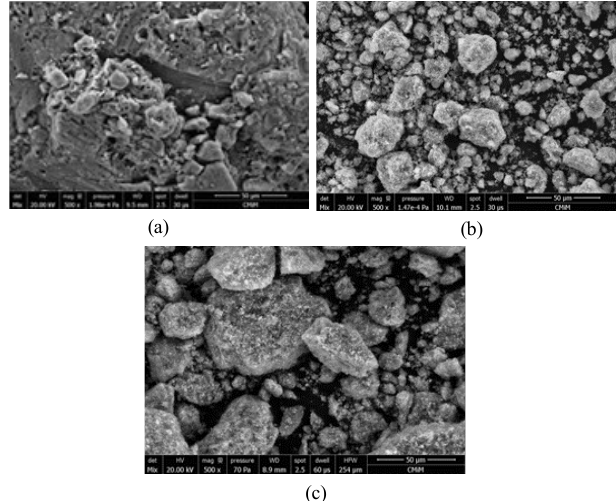
Fig. 1. SEM images of materials Mg/Al LDH (a) Mg/Al-TiO 2 (b) Mg/Al-ZnO